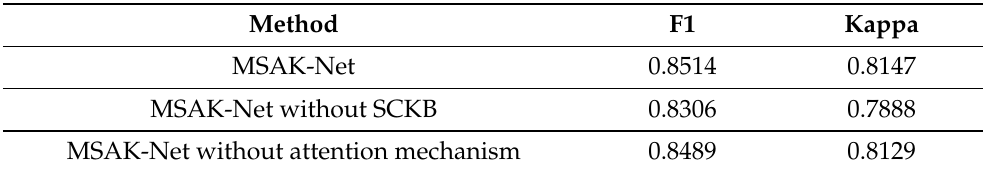
Figure 17. Ablation study of SCKB and attention mechanism on Tiazadob of SZTAKI datasets. ( a ) ground truth map of Tiszadob, ( b ) MSAK-Net of Tiszadob, ( c ) MSAK-Net without SCKB, ( d ) MSAK-Net without attention mechanism. Table 5. Ablation study of SCKB and attention mechanism of MSAK-Net on Tiazadob of SZ- TAKI